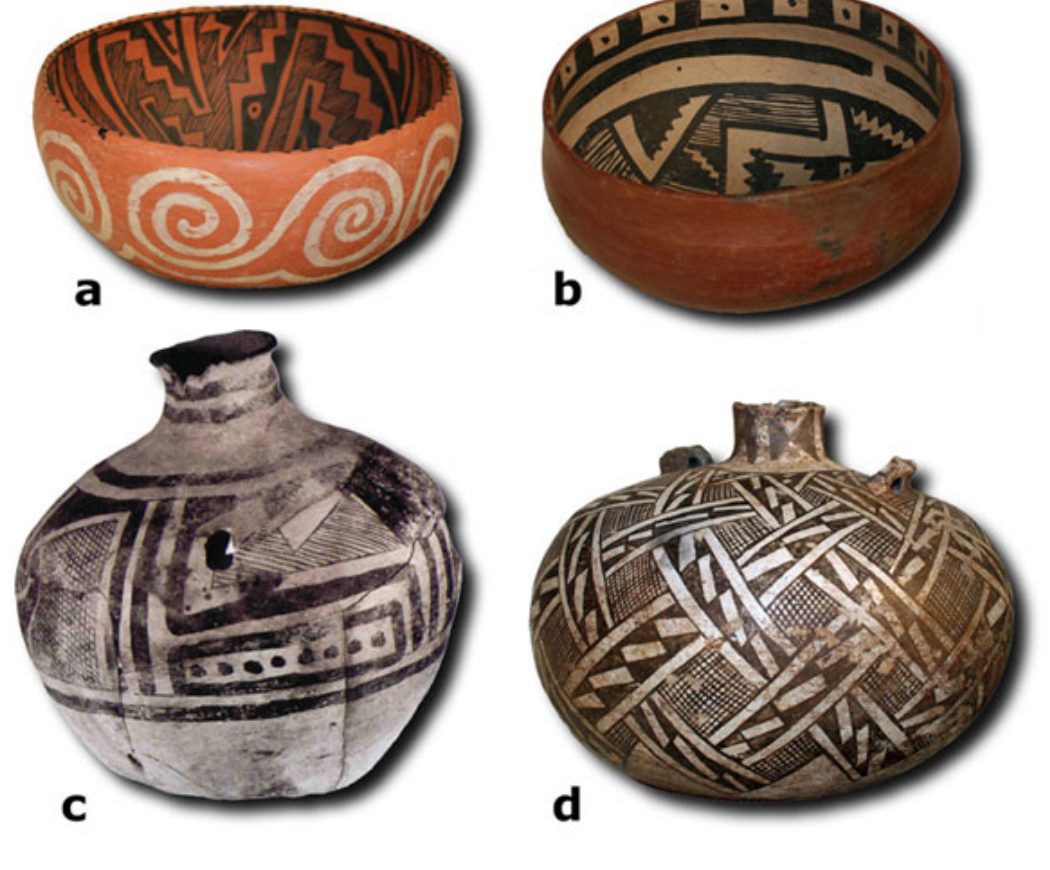
Fig. 7 . Examples of several prehistoric Southwestern painted ceramic wares: a) White Mountain Redware, manufactured in the Zuni region; b) Salado Polychrome, manufactured mainly in central and eastern Arizona; c) Salinas Whiteware, manufactured in the Salinas region; d) Cibola Whiteware, manufactured in the Zuni region. Each ware exhibits differences in slip and paint colors, location of painted designs on vessel surfaces, and the arrangement of painted designs within the painted